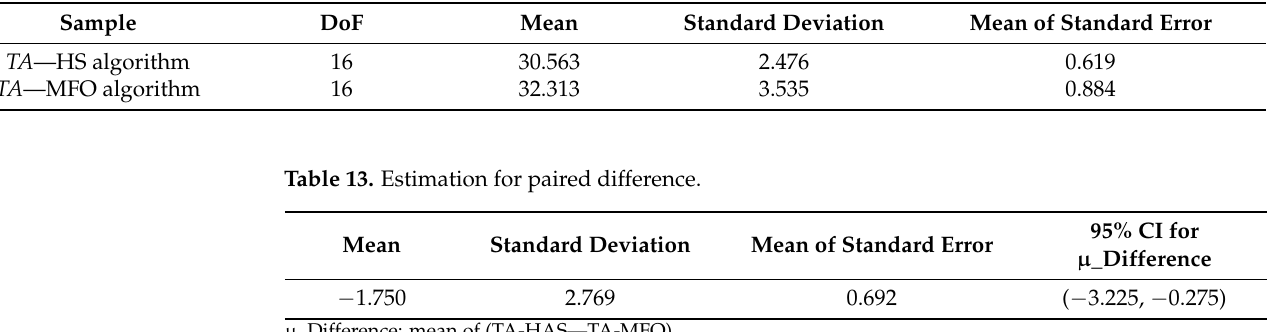
Table 12. Descriptive statistics.